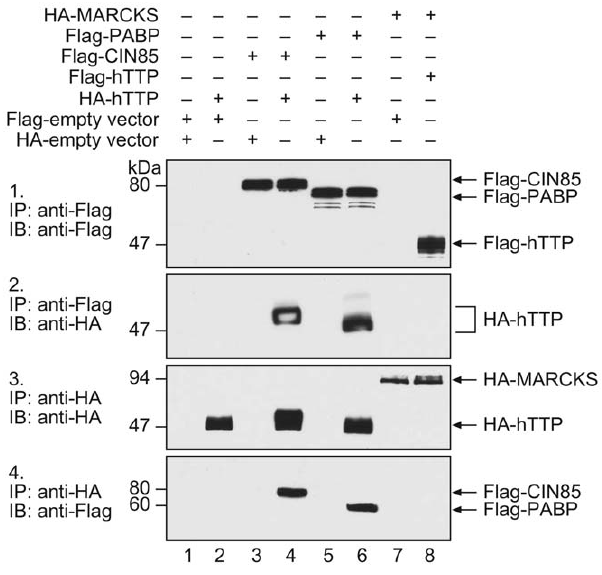
Figure 2. Interaction of TTP and with PABP and CIN85. Abbreviations and other details are as described in the legend to Fig.